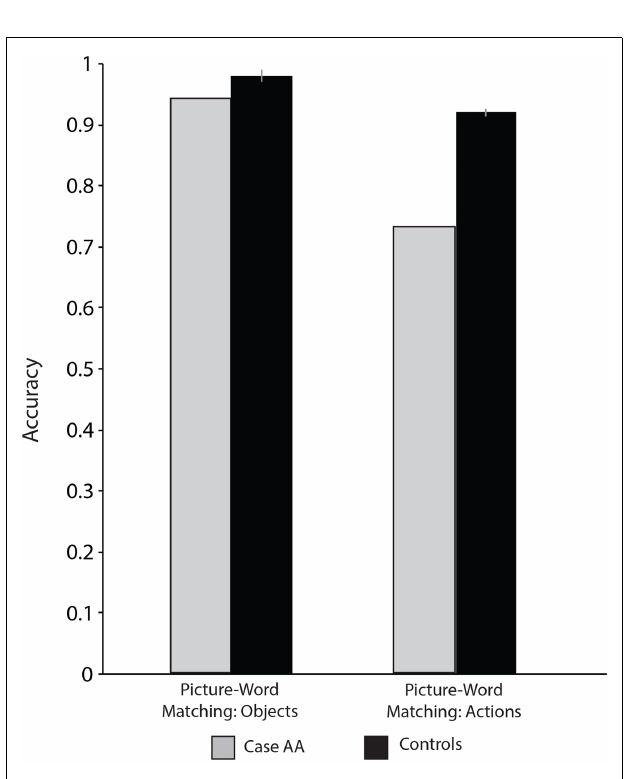
FIGURE 4 | CaseAA and controls’ picture-word matching accuracy with actions and